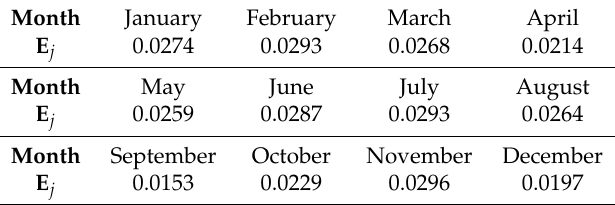
Table 2. Relative Error of Load Maximum Forecasting Results in 2015 Weekend.